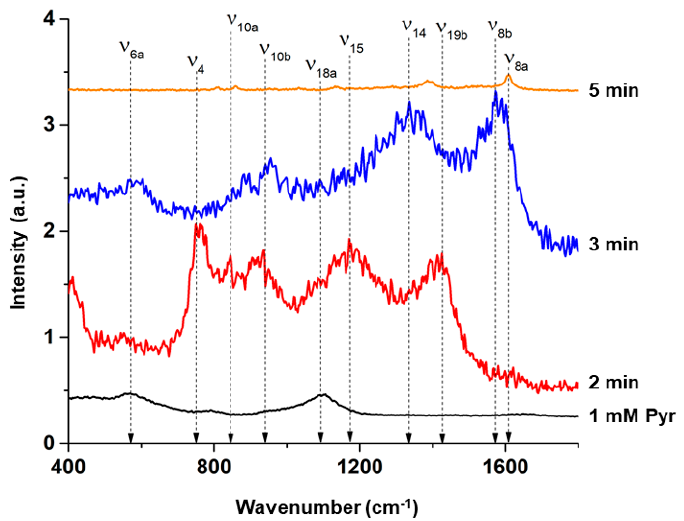
Figure 14. SERS spectra of 1 nM pyridine on supports doped at 2, 3, and 5 min with 20 mM AgNO 3 at